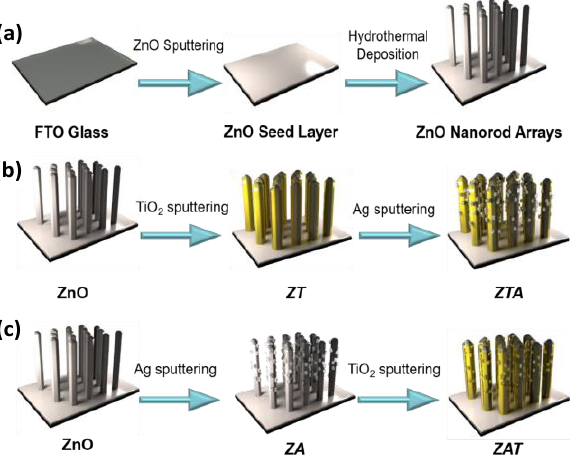
Figure 1. Schematics of the synthesize processes of samples based on ZnO nanorod arrays. ( a ) Hydrothermal growth of ZnO nanorod arrays, ( b ) ZT and ZTA structures, and ( c ) ZA and ZAT structures.